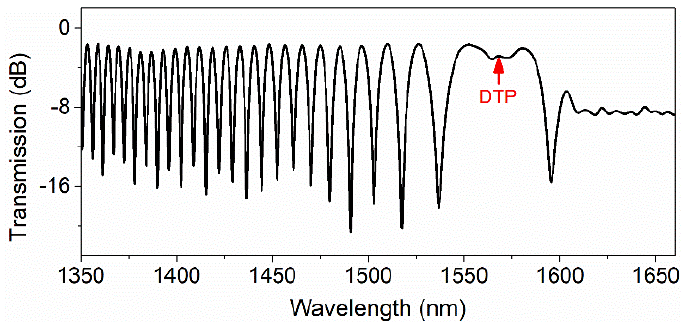
Figure 8. Spectrogram of the fabricated ONC with the DTP.